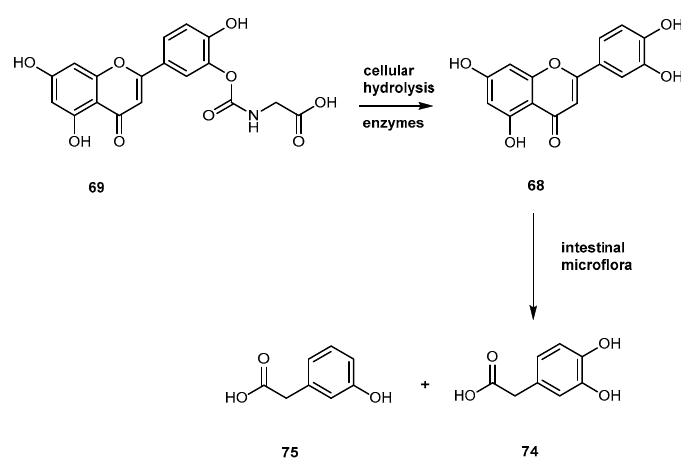
Figure 30. Bioconversion of a carbamate of 69 by cellular hydrolyzing enzymes and the proposed biotransformation to active metabolites, 74 and 75, by intestinal microflora (Reproduced from [4]).